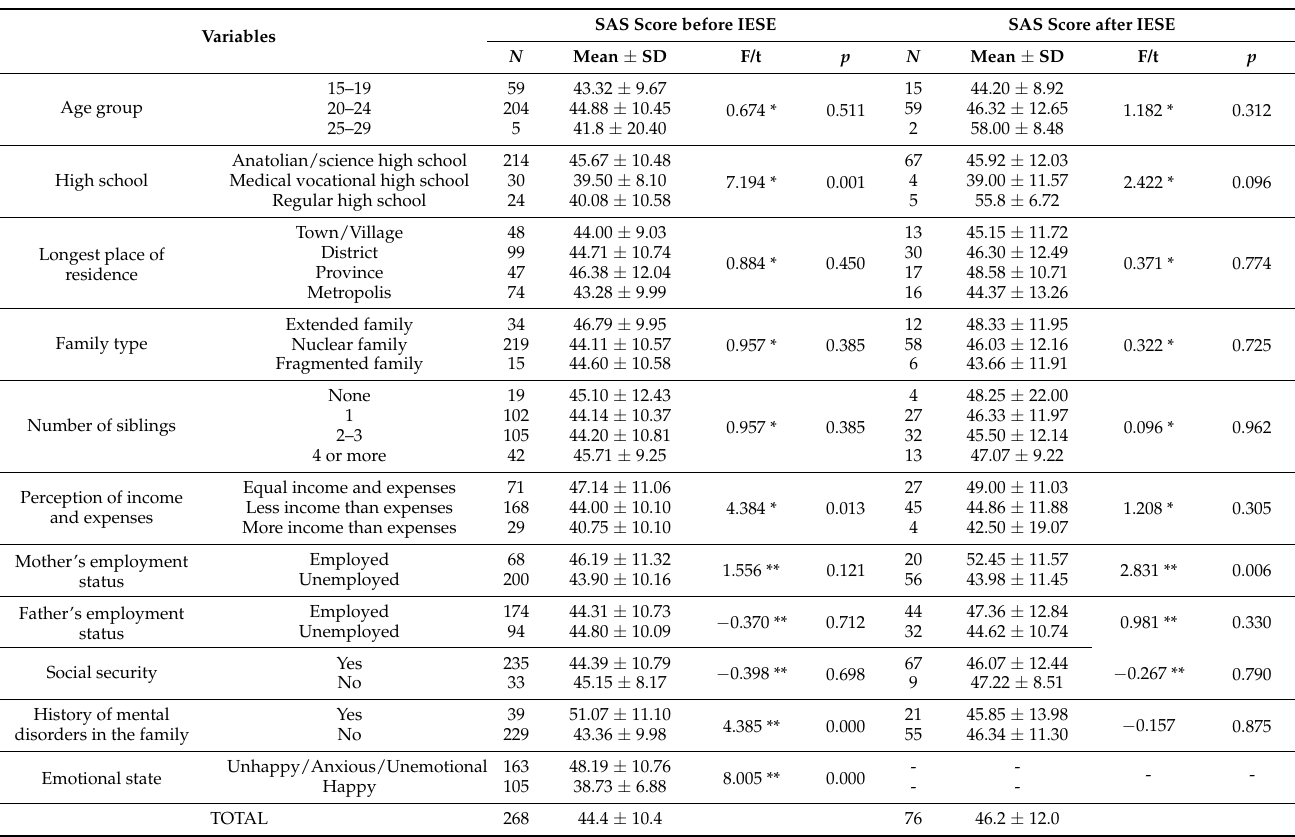
Table 3. Comparison of the participants’ mean SAS scores and their sociodemographic variables before and after the